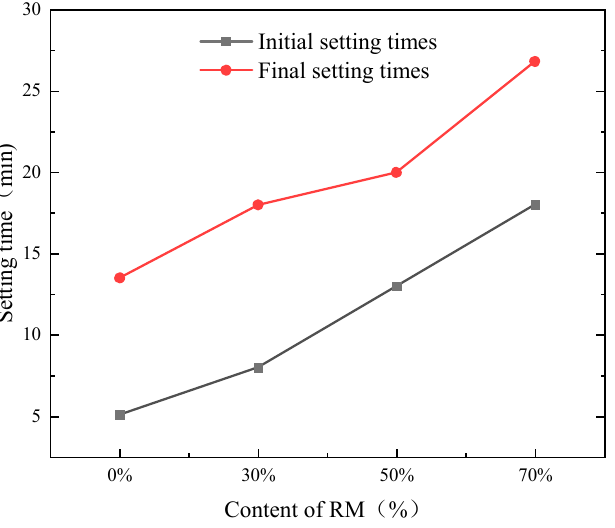
Figure 4. Effect of different red mud additions on the setting time of AASR.